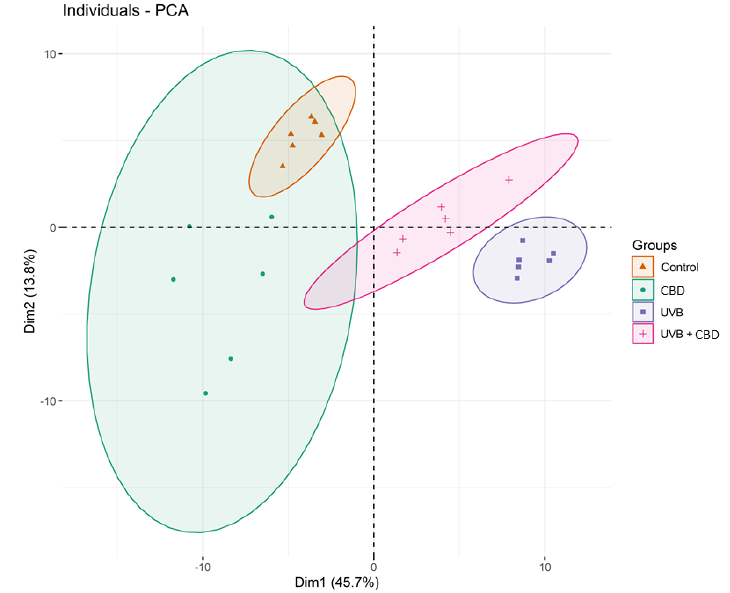
Figure 3. Principal component analysis (PCA) in a two-dimensional score plot of the relative abundance of phospholipid species in keratinocytes, isolated from the skin of healthy subjects (Control). These cells were not treated or treated with CBD (4 µ M) or / and UVB (60 mJ / cm 2 ). The following groups of keratinocytes were studied: Control, CBD, UVB, and UVB + CBD. All samples were analyzed after 24 h of treatment.